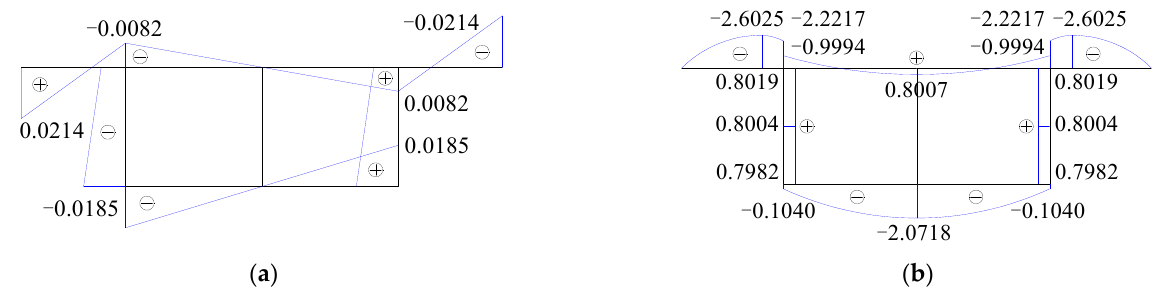
ω ; ( b ) ω S . Figure 10. Geometric characteristics of the section (unit: 10 − 5 m 4 ): ( a ) ω ; ( b ) S ω